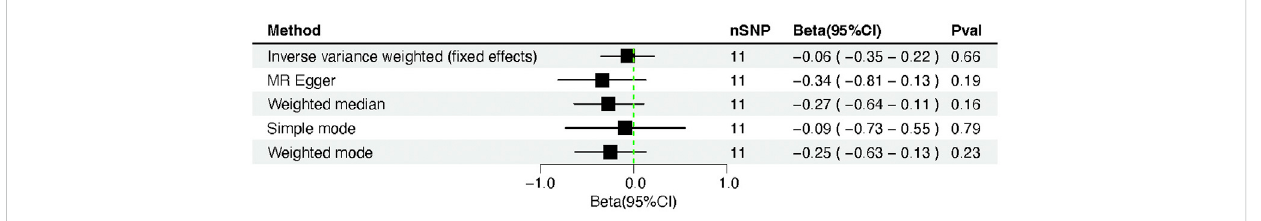
FIGURE 2 Forest plot of Mendelian randomization analysis between COVID-19 susceptibility and cardiac injury risk.